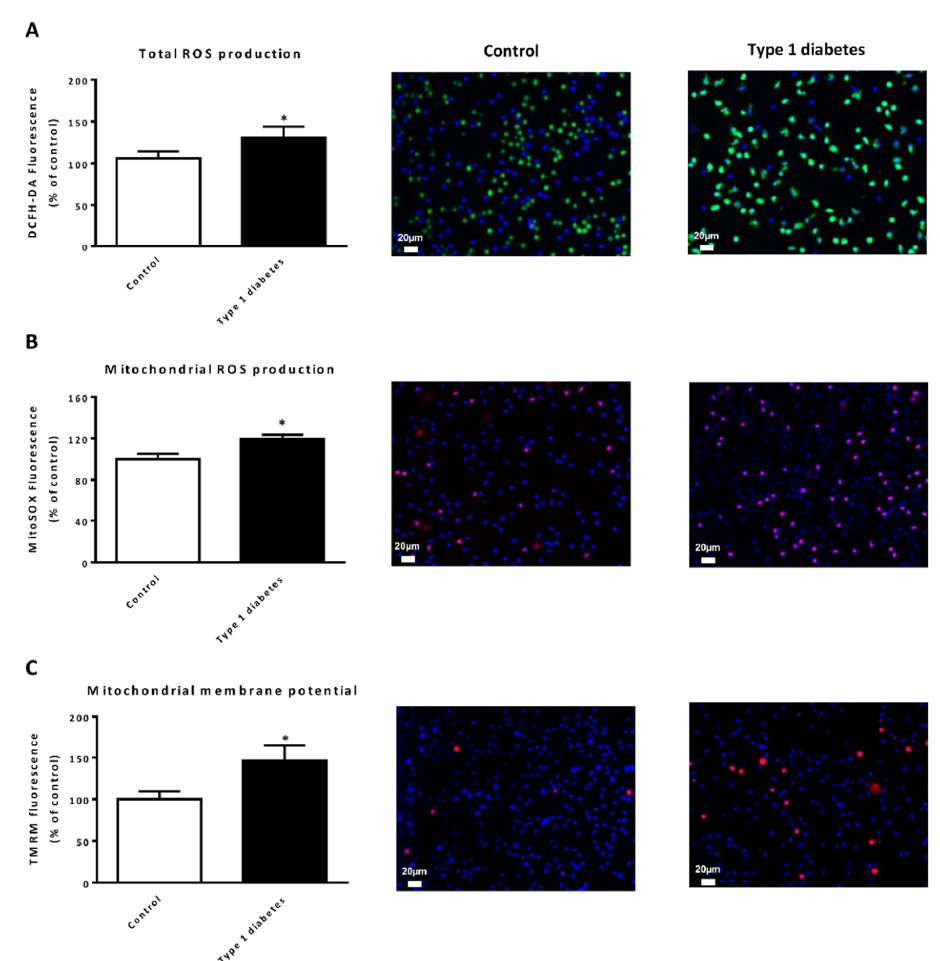
Figure 1. Evaluation of oxidative stress (total and mitochondrial ROS production) and mitochondrial membrane potential in type 1 diabetic and control subjects. ( A ) Levels of total ROS production measured as DCFH-DA fluorescence. Representative images of leukocytes stained with DCFH-DA (green) and Hoechst 33,342 (blue) and visualized by fluorescence microscopy. ( B ) Levels of mitochondrial ROS production measured as MitoSOX red fluorescence. Representative images of leukocytes stained with MitoSOX (red) and Hoechst 33,342 (blue) by fluorescence microscopy. ( C ) Mitochondrial membrane potential measured as TMRM fluorescence. Representative images of leukocytes stained with TMRM (red) and Hoechst 33,342 (blue) and visualized by fluorescence microscopy. Fluorescence was measured as arbitrary units of fluorescence and expressed as % of control fluorescence. Data are expressed as mean ± SEM. * p < 0.05 control vs. type 1 diabetic subjects.